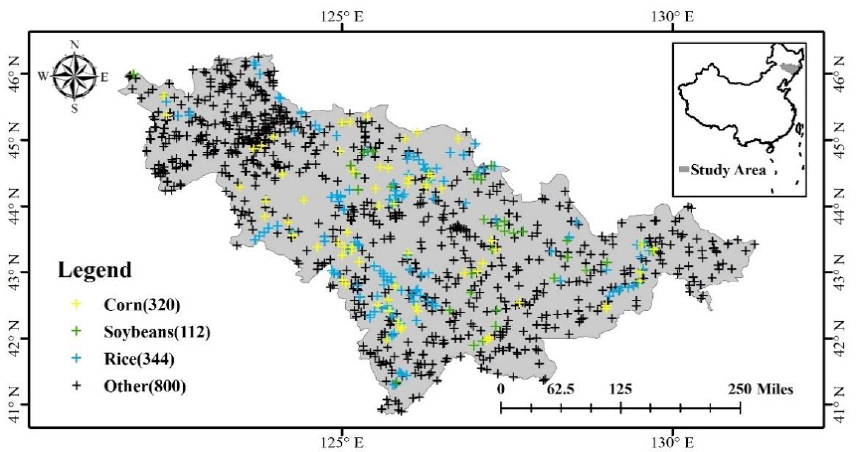
Figure 1. Study area and validation point distribution. Numbers in parentheses indicate the number of sample points.